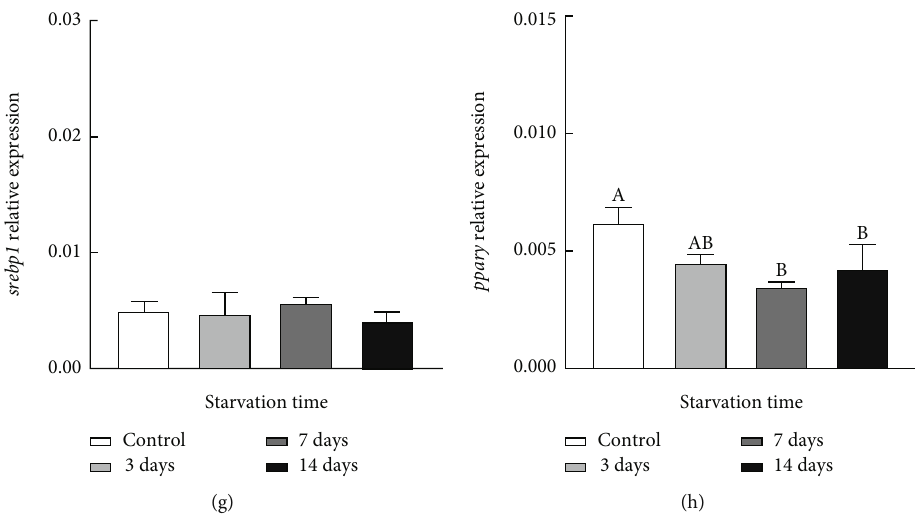
Figure 4: E ff ects of starvation on lipid metabolism-related gene expression in the muscle of Synechogobius hasta . Relative expression abundances of fas (a), scd1 (b), lpl (c), cpt1a (d), fatp1 (e), fabp3 (f), srebp1 (g), and ppar γ (h) in the muscle of starved S. hasta . The transcript level was measured by quantitative real-time PCR (qRT-PCR) and normalized to the abundance of a housekeeping gene ( β - actin). All data were represented as means ± SD ( n = 4 − 5 ), and di ff erences between groups were determined via one-way ANOVA. Columns with di ff erent letters were deemed signi fi cantly di ff erent ( P < 0 : 05 ). Table 2: Summary of the muscular transcriptome data in this study.